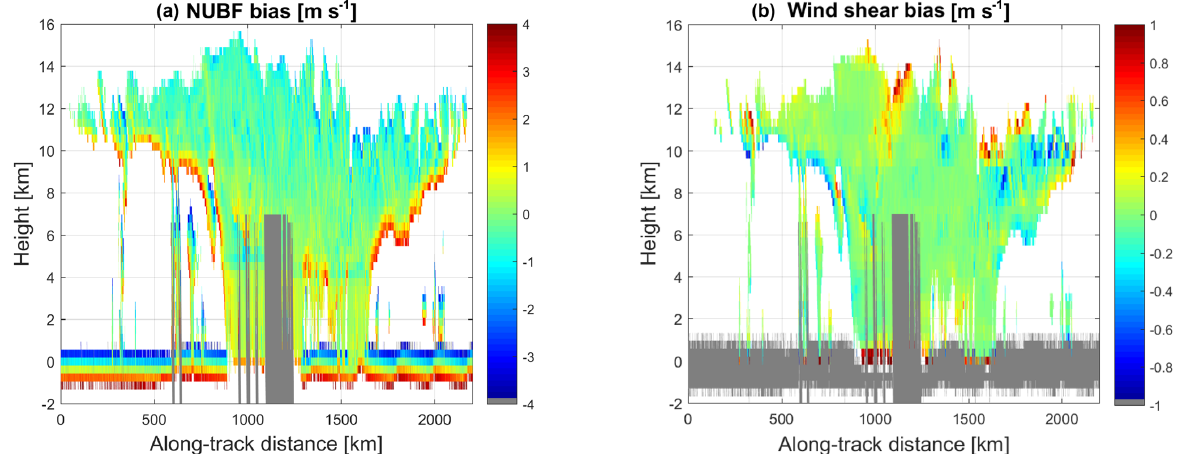
Figure 8. NUBF-induced (a) and wind-shear-induced (b) errors for the Hurricane Igor scene shown in Fig. 6. Most of the biases are near the cloud edge; widespread biases of ∼ 1ms − 1 must be avoided.